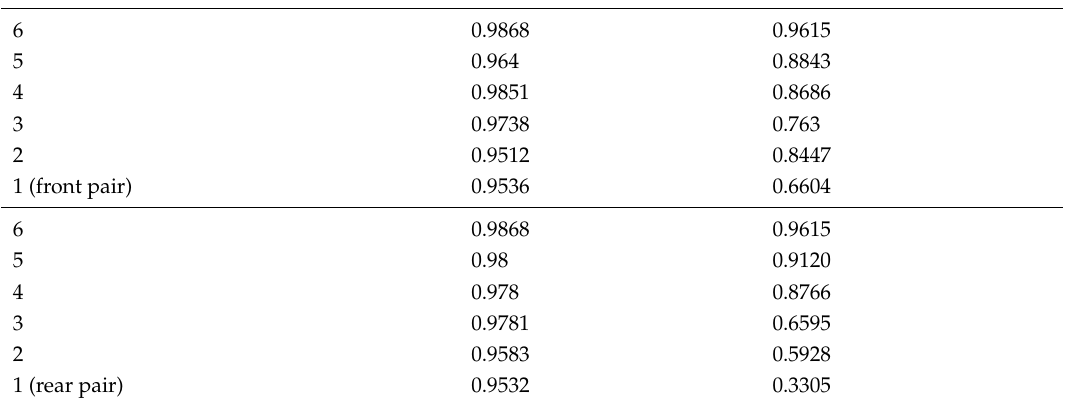
Table 2. Sensitivity of the prediction accuracy (mean [ R ] ) of the ( x , y ) models to the number of whisker pairs included in the training stage. The number is varied in the front-to-rear direction of the whiskers (top) and vice versa